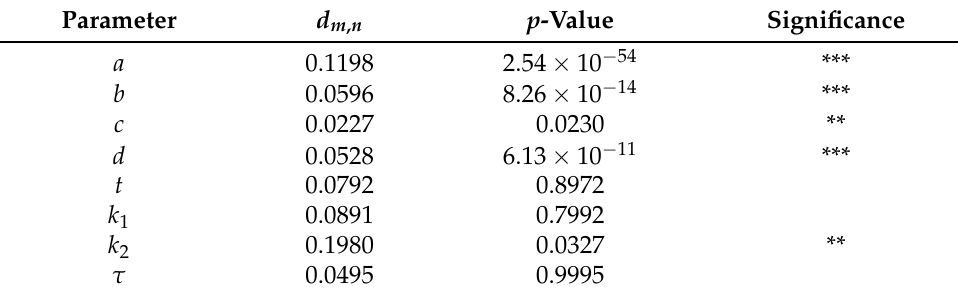
Table 2. RSA results for AA − DA comparison.